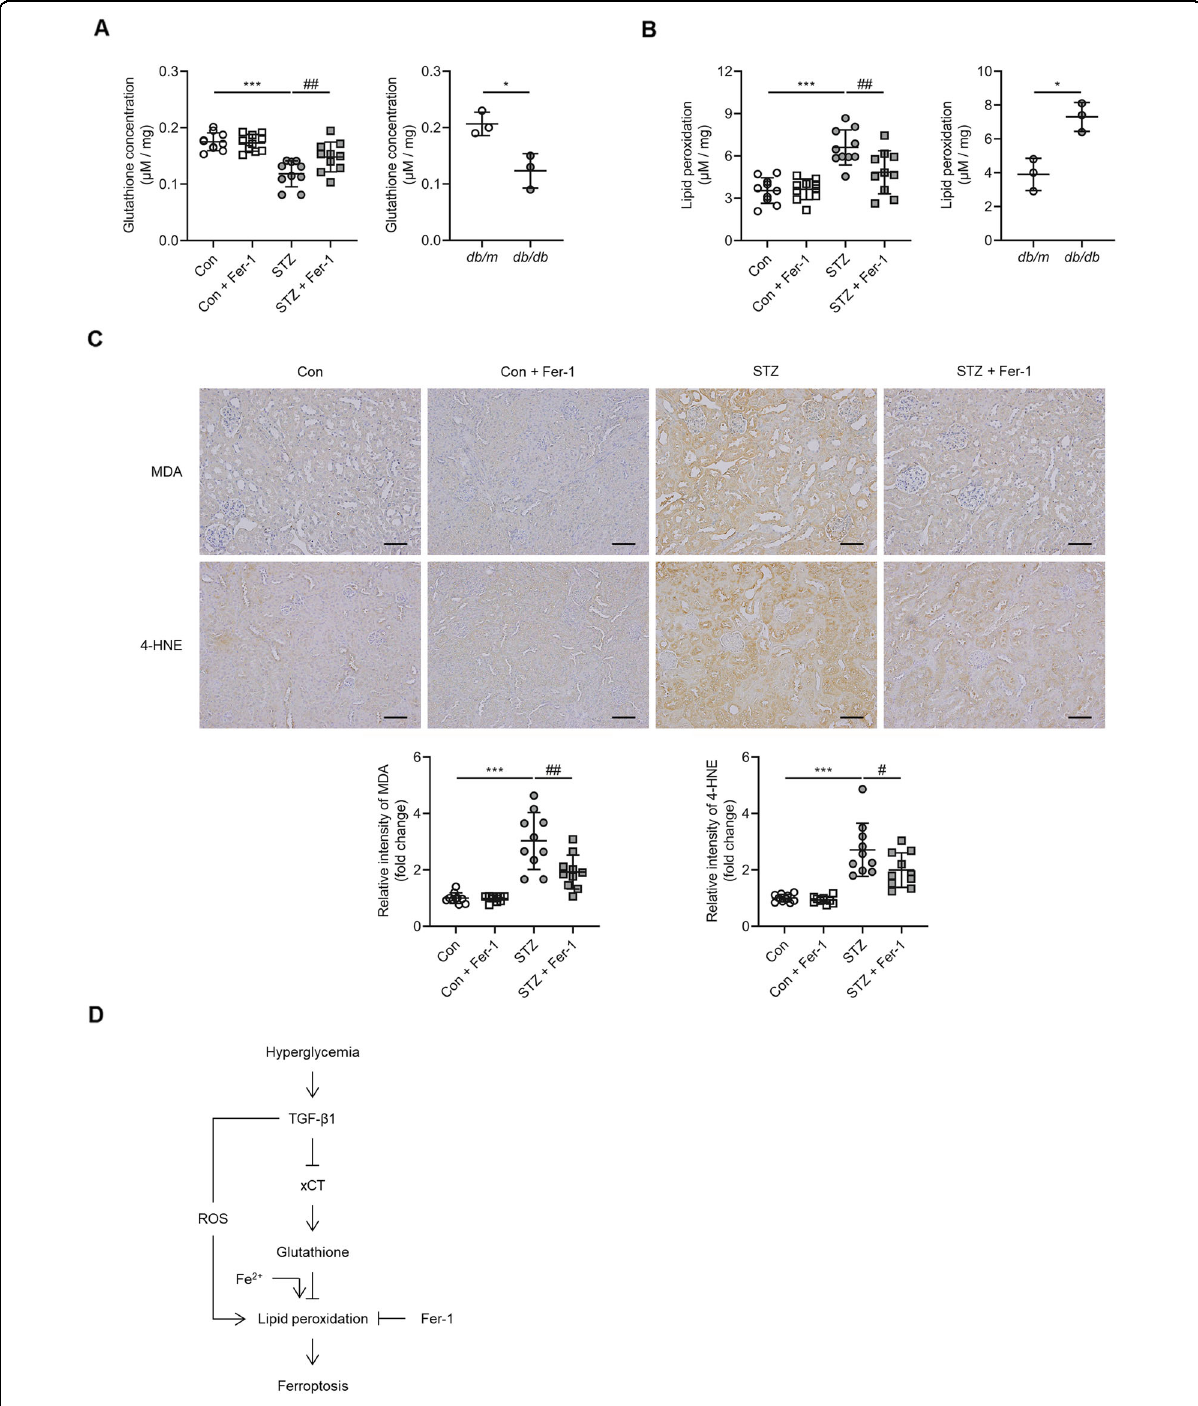
Fig. 6 Effect of Fer-1 on glutathione concentration and lipid peroxidation in the kidney of diabetic mice. A Glutathione concentration in the kidneys of STZ and db/db mice. B Lipid peroxidation assessed by MDA levels in the kidneys of STZ and db/db mice. C Immunohistochemistry for MDA and 4-HNE was signi fi cantly increased in the STZ group, and this was abrogated by administration of Fer-1. D Schematic diagram of TGF- β 1-induced ferroptosis in diabetic nephropathy. One-way ANOVA and Bonferroni post hoc tests were used for statistical analysis. Error bars represent SD. Original magni fi cation, ×20 for all. Scale bar = 100 µm. * P < 0.05; *** P < 0.001 versus Con group. # P < 0.05; ## P < 0.01 versus STZ group; ROS reactive oxygen species. n = 10 for each group of STZ. n = 3 for each group of db/db